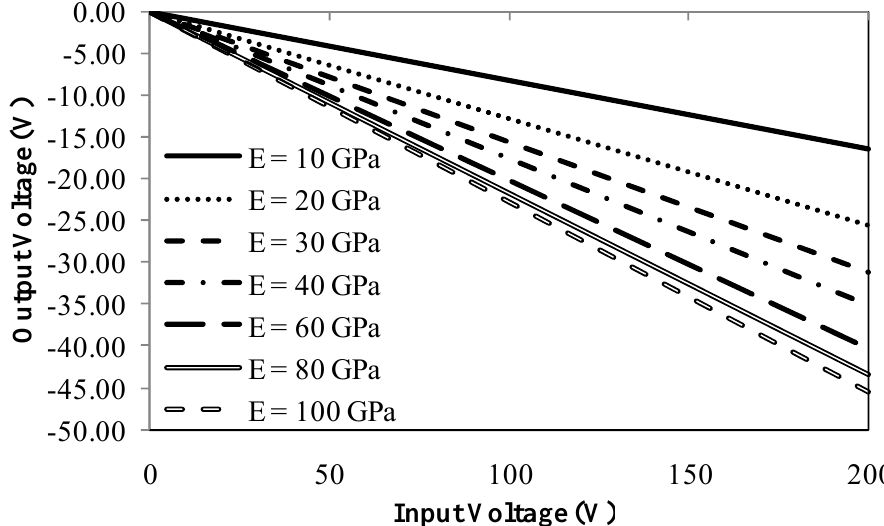
Figure 12. Induced voltage resulting from applied voltage for a range of test specimen